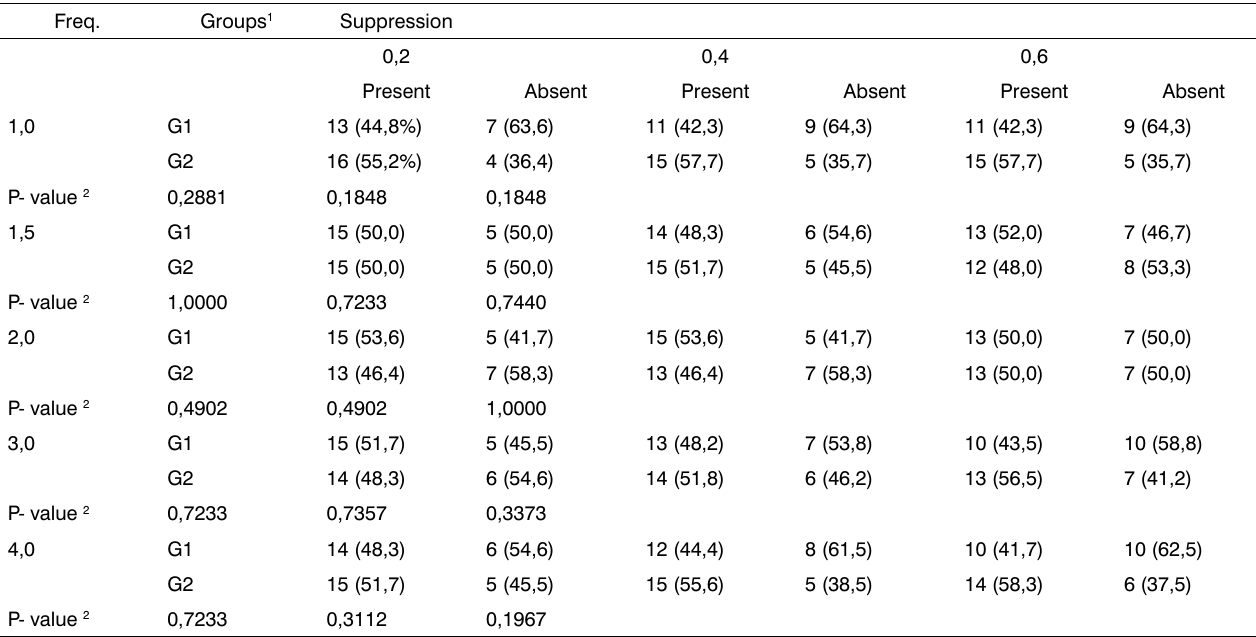
Table 1. Percentages of subjects with present or absent TEOAE suppression at 0.2, 0.4 or 0.6 dB as the minimum suppression levels in the given